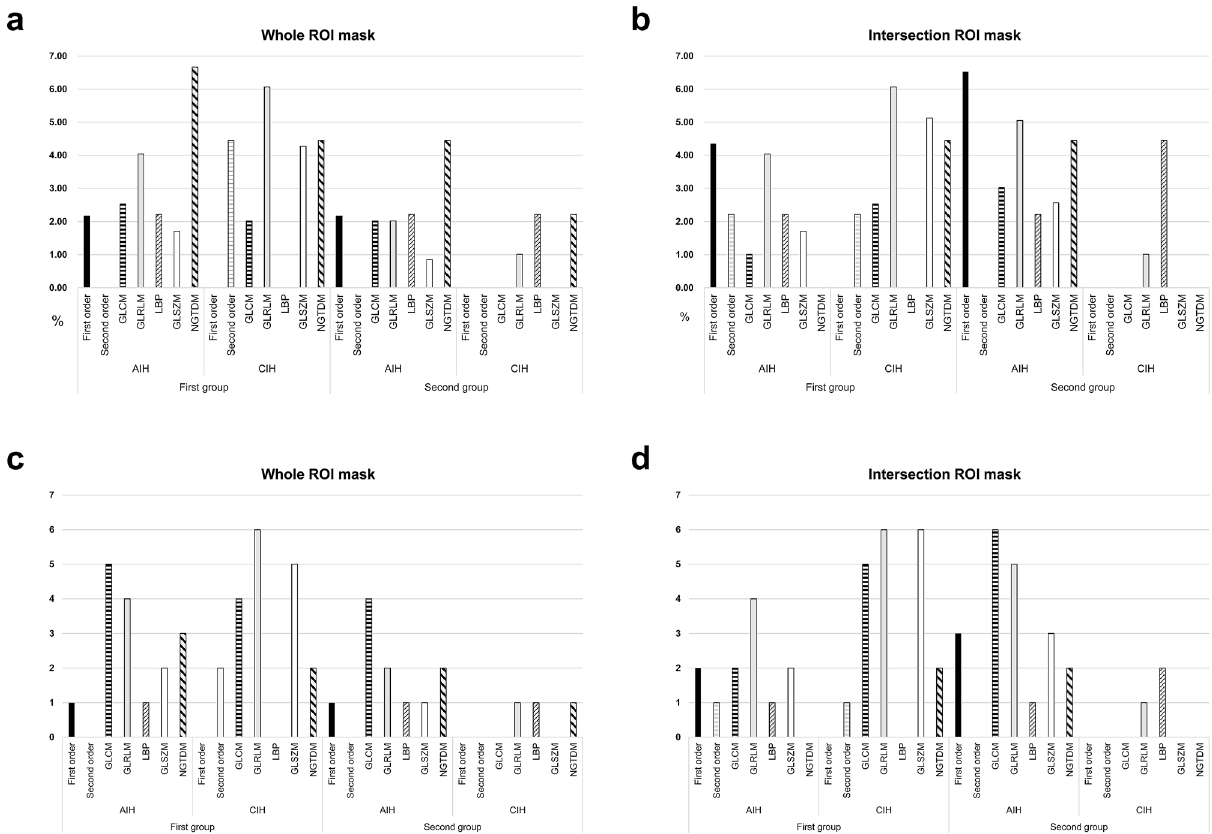
Figure 3. Proportions of stable radiomic features throughout both fast scanned T2-FLAIR sequences extracted from whole- and intersection ROI masks in the first and second groups. (a,b) Proportions of stable radiomic features from whole ROI masks (a) and intersection ROI masks (b) . (c,d) Numbers of stable radiomic features from whole ROI masks (c) and intersection ROI masks (d) . AIH acute ischemic hyperintensity, CIH chronic ischemic hyperintensity, ROI region-of-interest, EPI echo-planar imaging, ETL echo train length, TR repetition time, GLCM gray-level co-occurrence matrix, GLRLM gray-level run-length matrix, LBP local binary pattern, GLSZM gray-level size zone matric, NGTDM neighboring gray tone difference matrix.